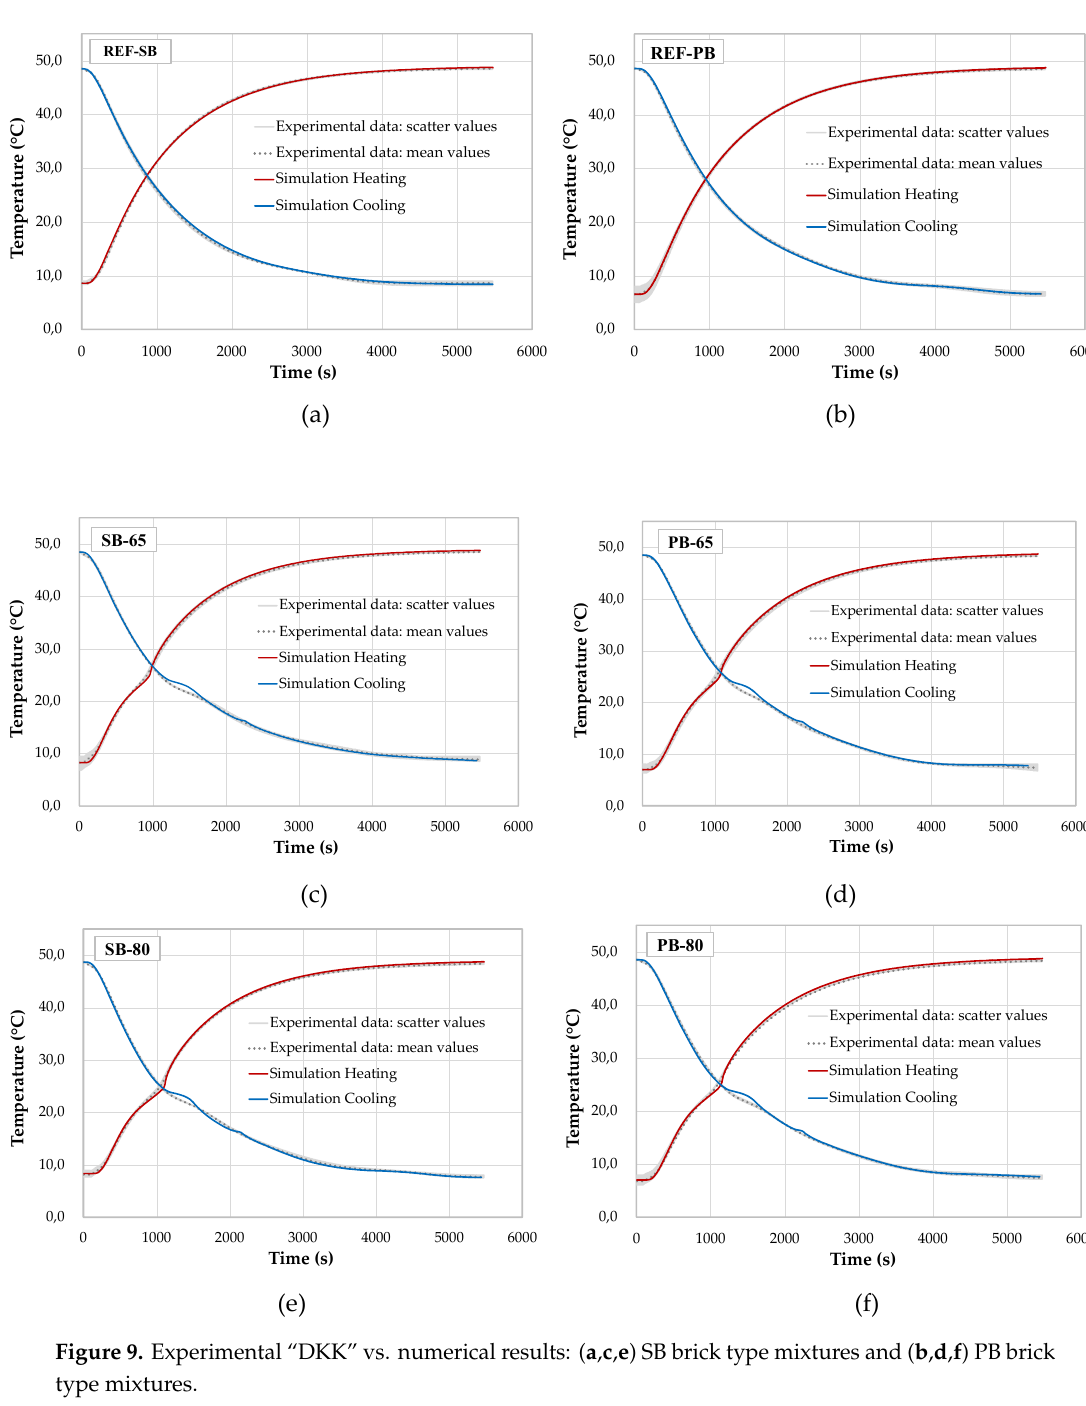
Figure 9. Experimental “DKK” vs. numerical results: ( a , c , e ) SB brick type mixtures and ( b , d , f ) PB brick type mixtures.